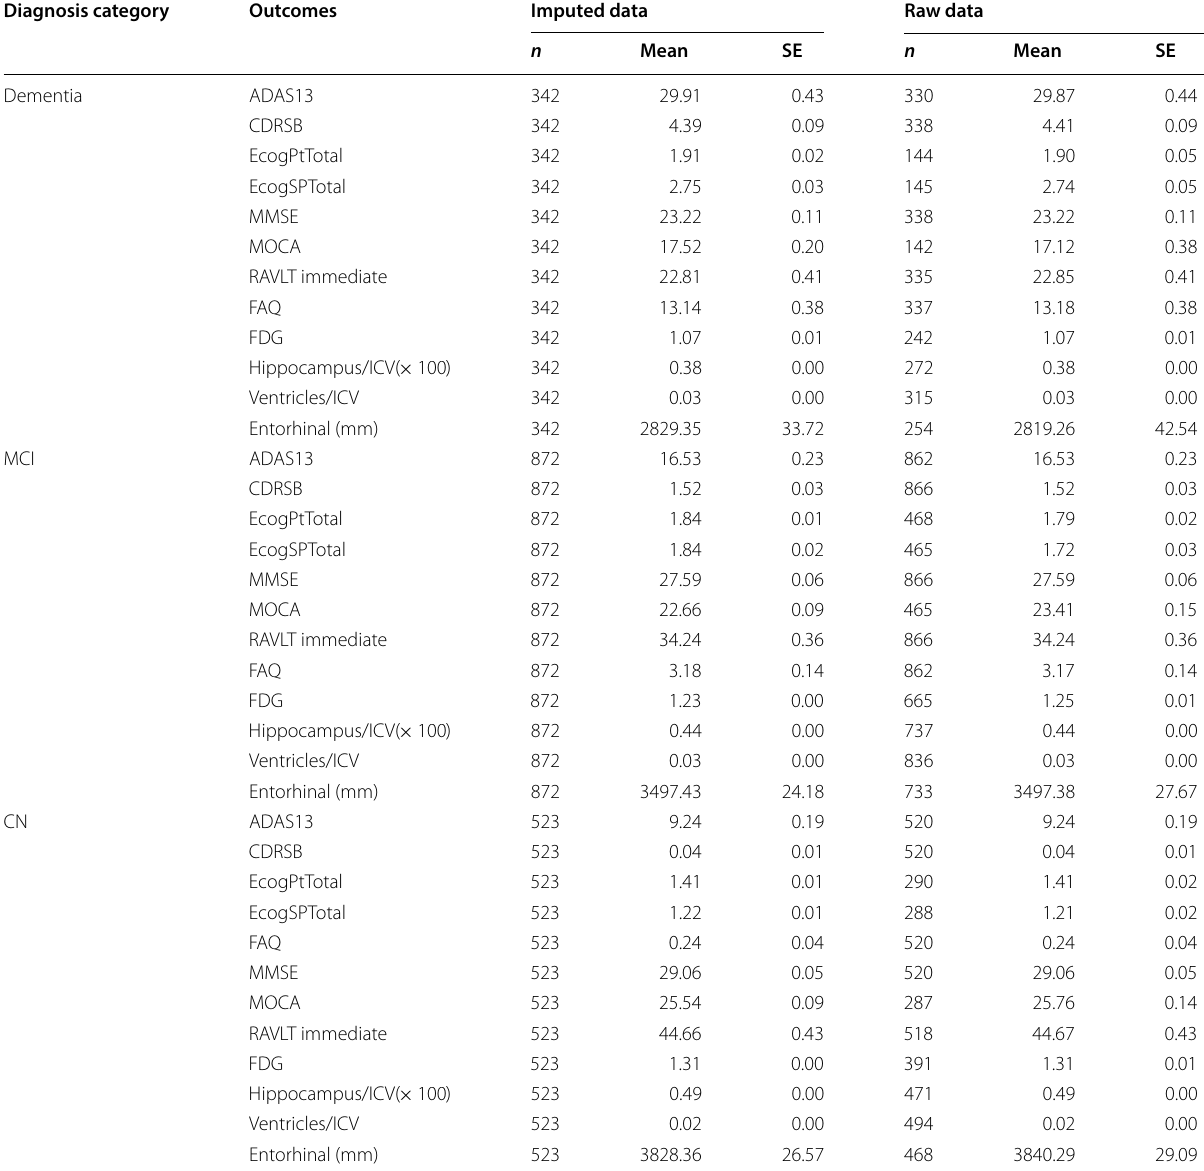
Table 1 Summary measures at baseline for raw and imputed